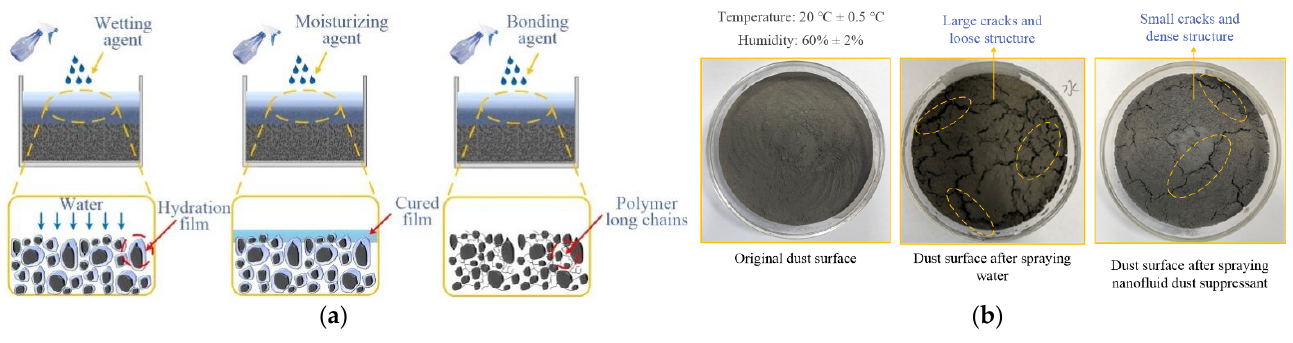
Figure 1. The mechanism of dust suppression and the experimental photos of dust surface. ( a ) The mechanism of dust suppression. ( b ) The experimental photos of dust surface.